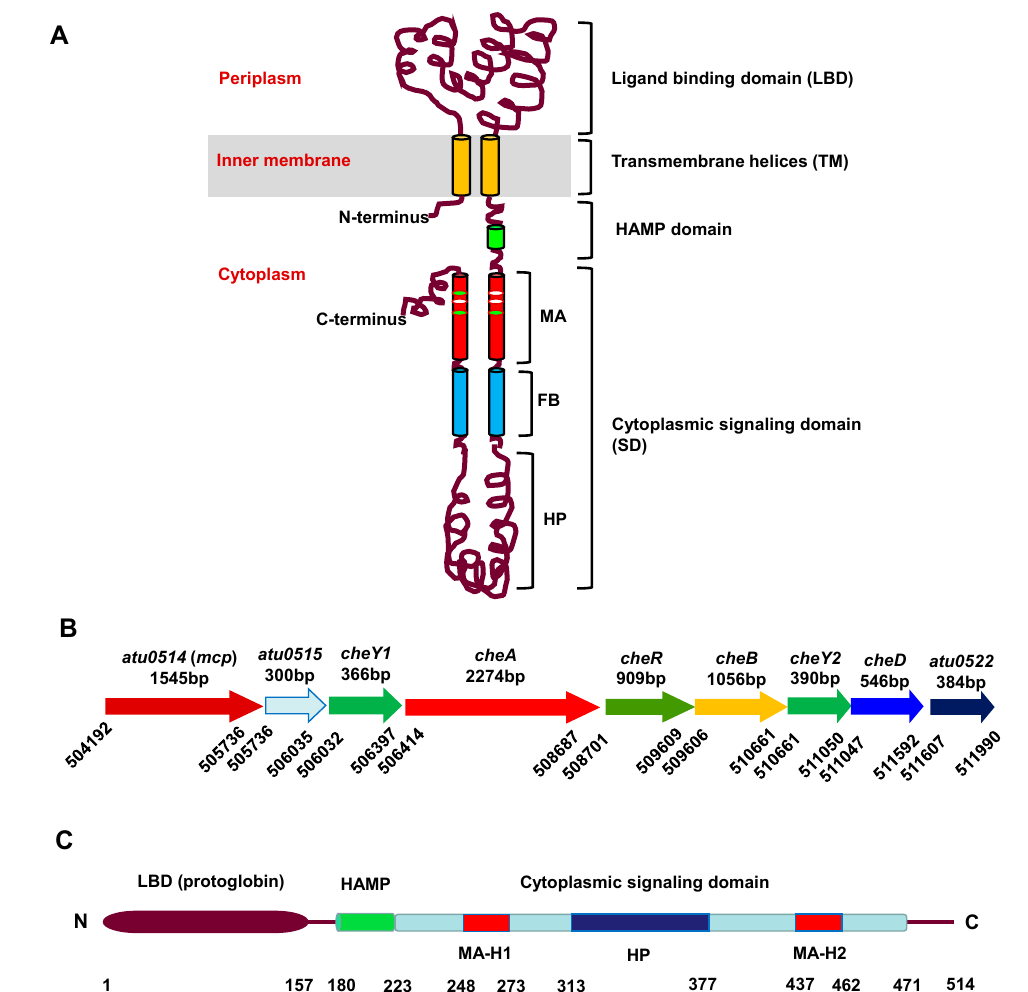
Figure 1. Topological structure of a typical MCP, gene organization of a A. fabrum che gene cluster and domain organization of MCP 514 . ( A ) Architectural model of a typical MCP. Cylinders represent α -helices. MA: methyl-accepting (or sensory adaptation) subdomain; FB: flexible bundle subdomain; HP: hairpin subdomain. ( B ) Gene organization of A. fabrum che gene cluster. Arrows represent genes. Above the arrows are the names and lengths of the genes. Numbers under the arrows indicate the nucleotide position of the gene border. ( C ) Predicted domain organization of MCP 514 . MA-H1: α -helix 1 of MA subdomain; MA-H2: α -helix 2 of MA subdomain; numbers under the domains indicate the amino acid position of the domain border.